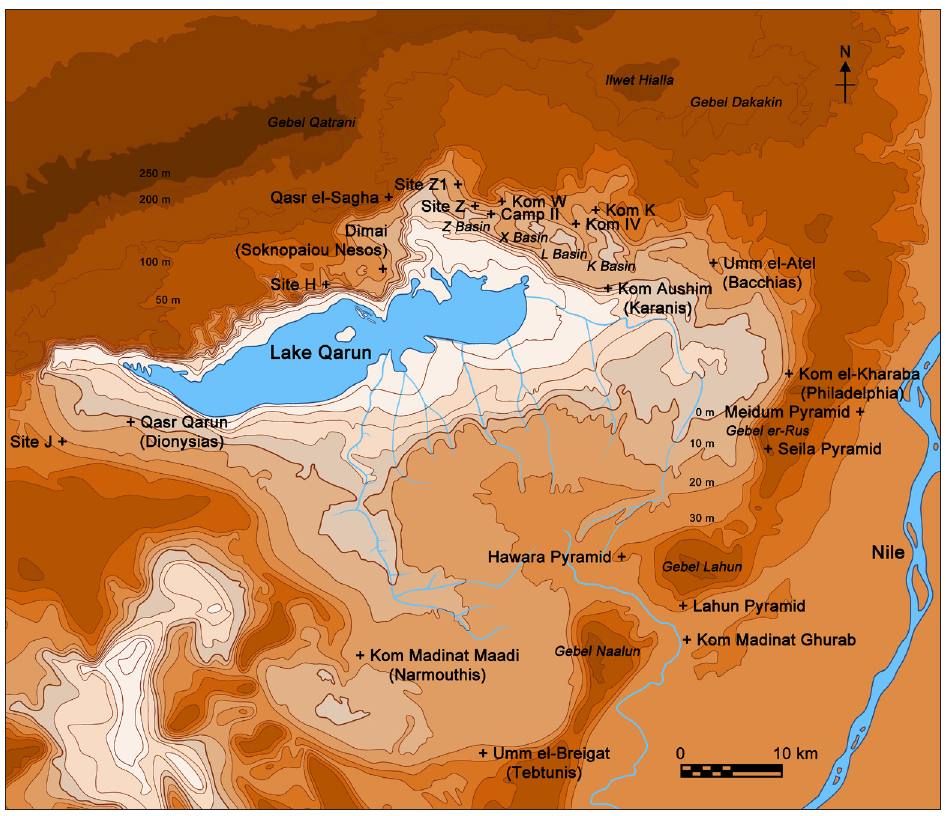
Figure 1: Map of the Fayum (Drawn by